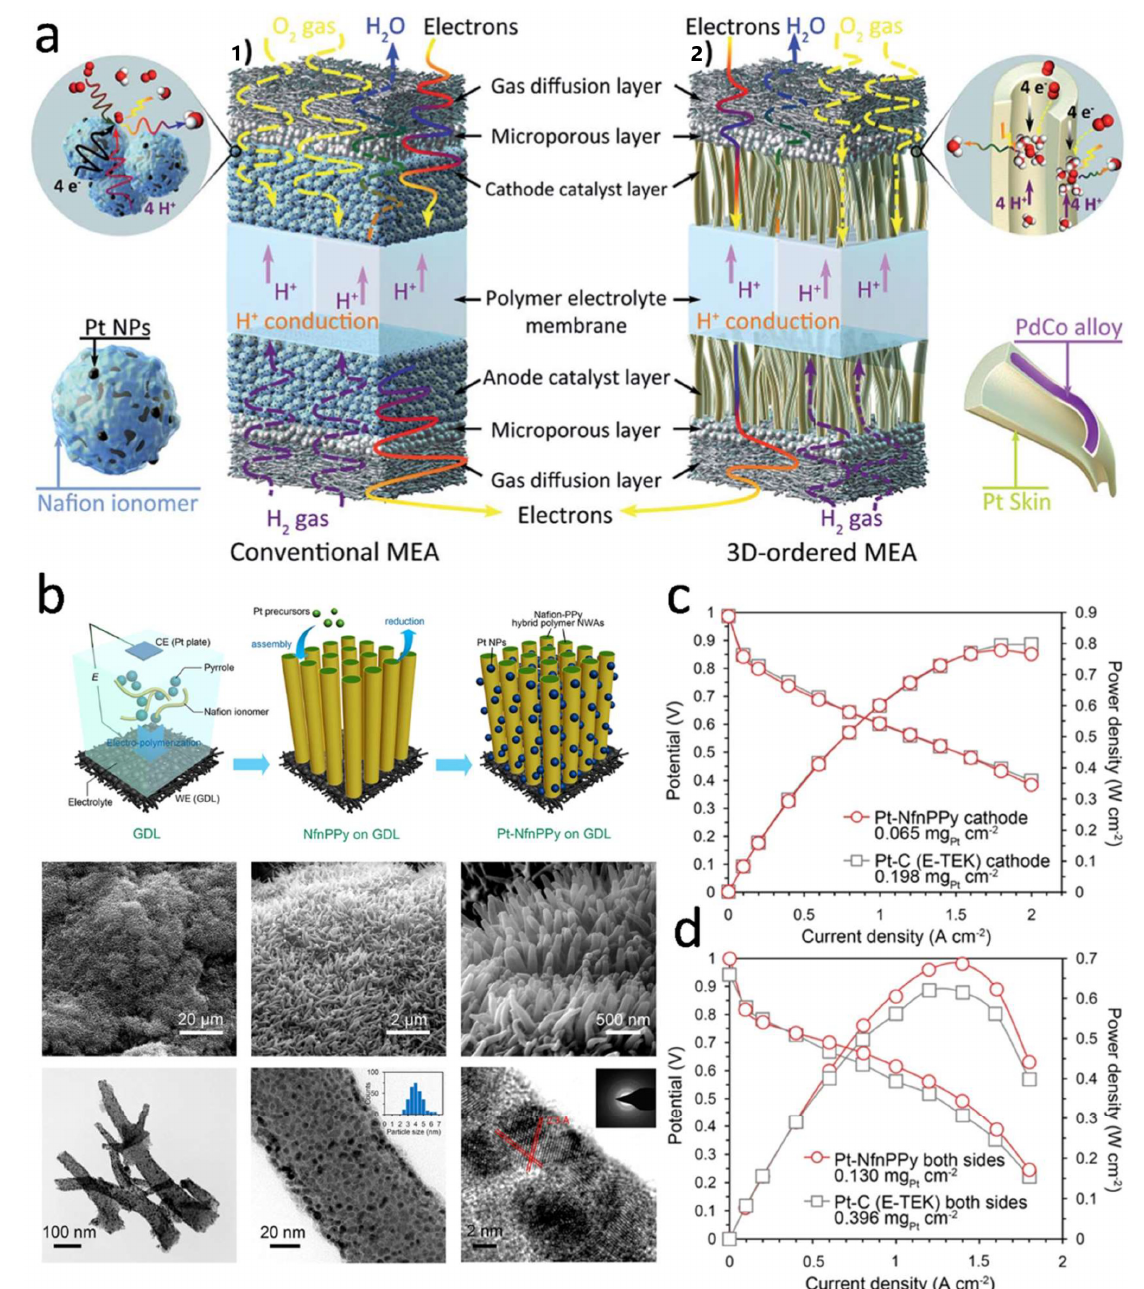
Figure 11. ( a ) Conceptual diagrams of ( a1 ) conventional MEA and ( a2 ) 3D-ordered MEA. Reproduced from Ref. [172] with permission from Royal Society of Chemistry, copyright 2018. ( b ) Schematic of the preparation and formation of Pt-NfnPPy electrode arrays; ( c ) Polarization curves in a fully humidified H 2 /O 2 supplement at 70 ◦ C; ( d ) Polarization curves of PEMFC equipped with Pt-NfnPPy and conventional Pt/C electrode on both sides of the MEA in a fully humidified H 2 /air supplement at 70 ◦ C. Reproduced from Ref. [175] with permission from Springer Nature, copyright